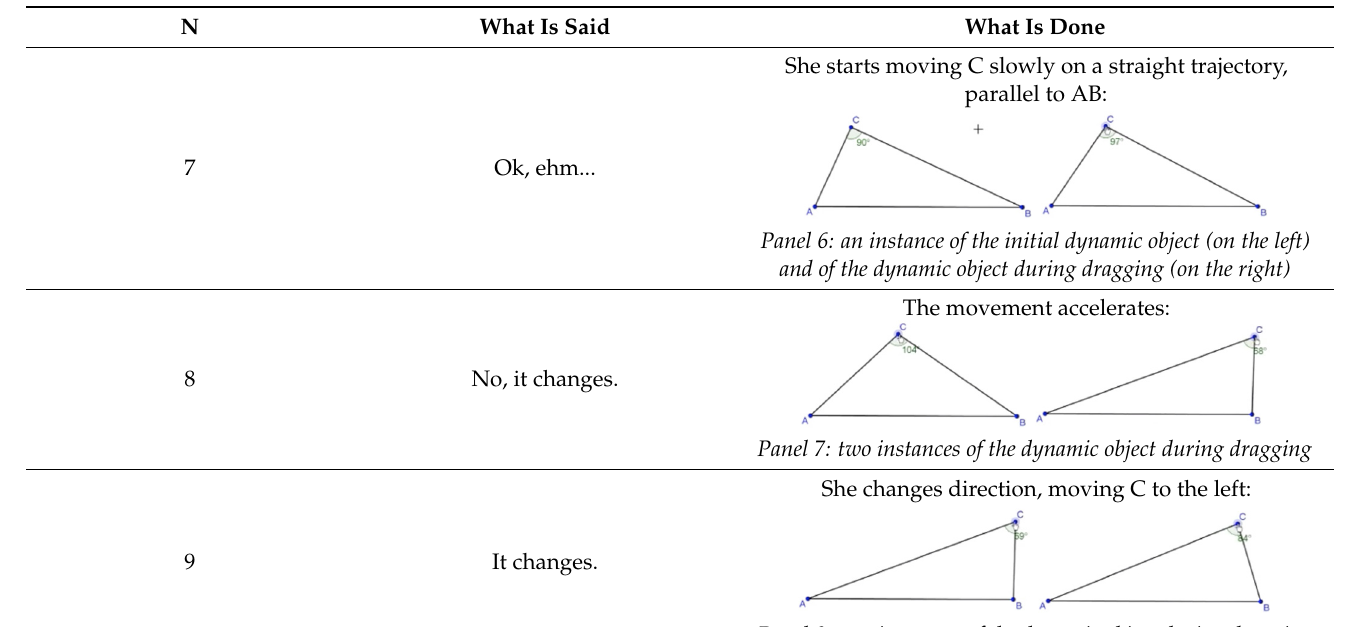
Panel 8: two instances of the dynamic object during dragging Table 6. Main elements from the analysis of Excerpt 3.